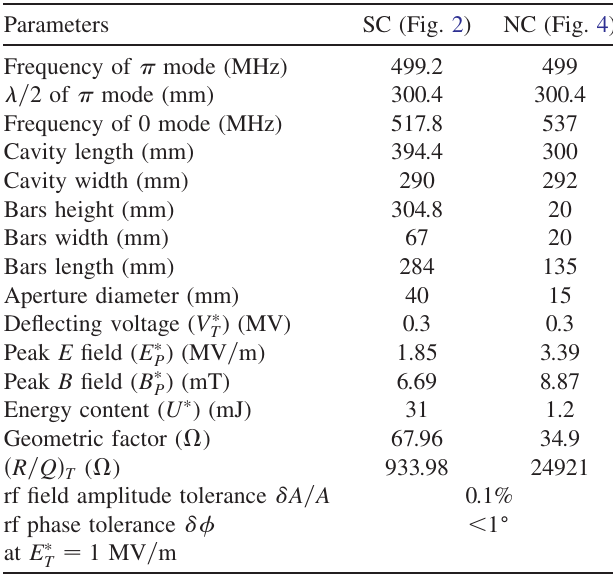
TABLE I. Properties of structures as shown in Figs. 2 and 4.